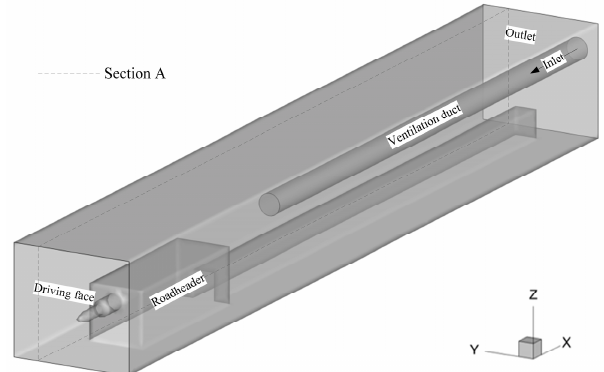
Figure 1. Schematic views of the laneway model.